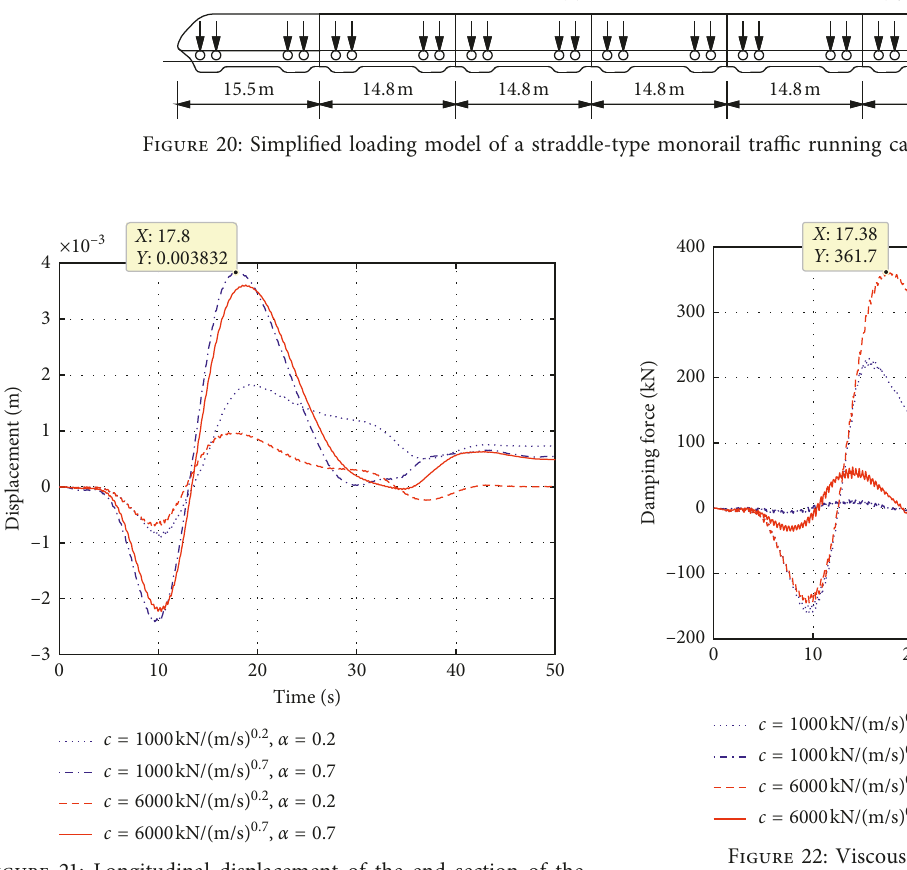
Figure 21: Longitudinal displacement of the end section of the main girder.